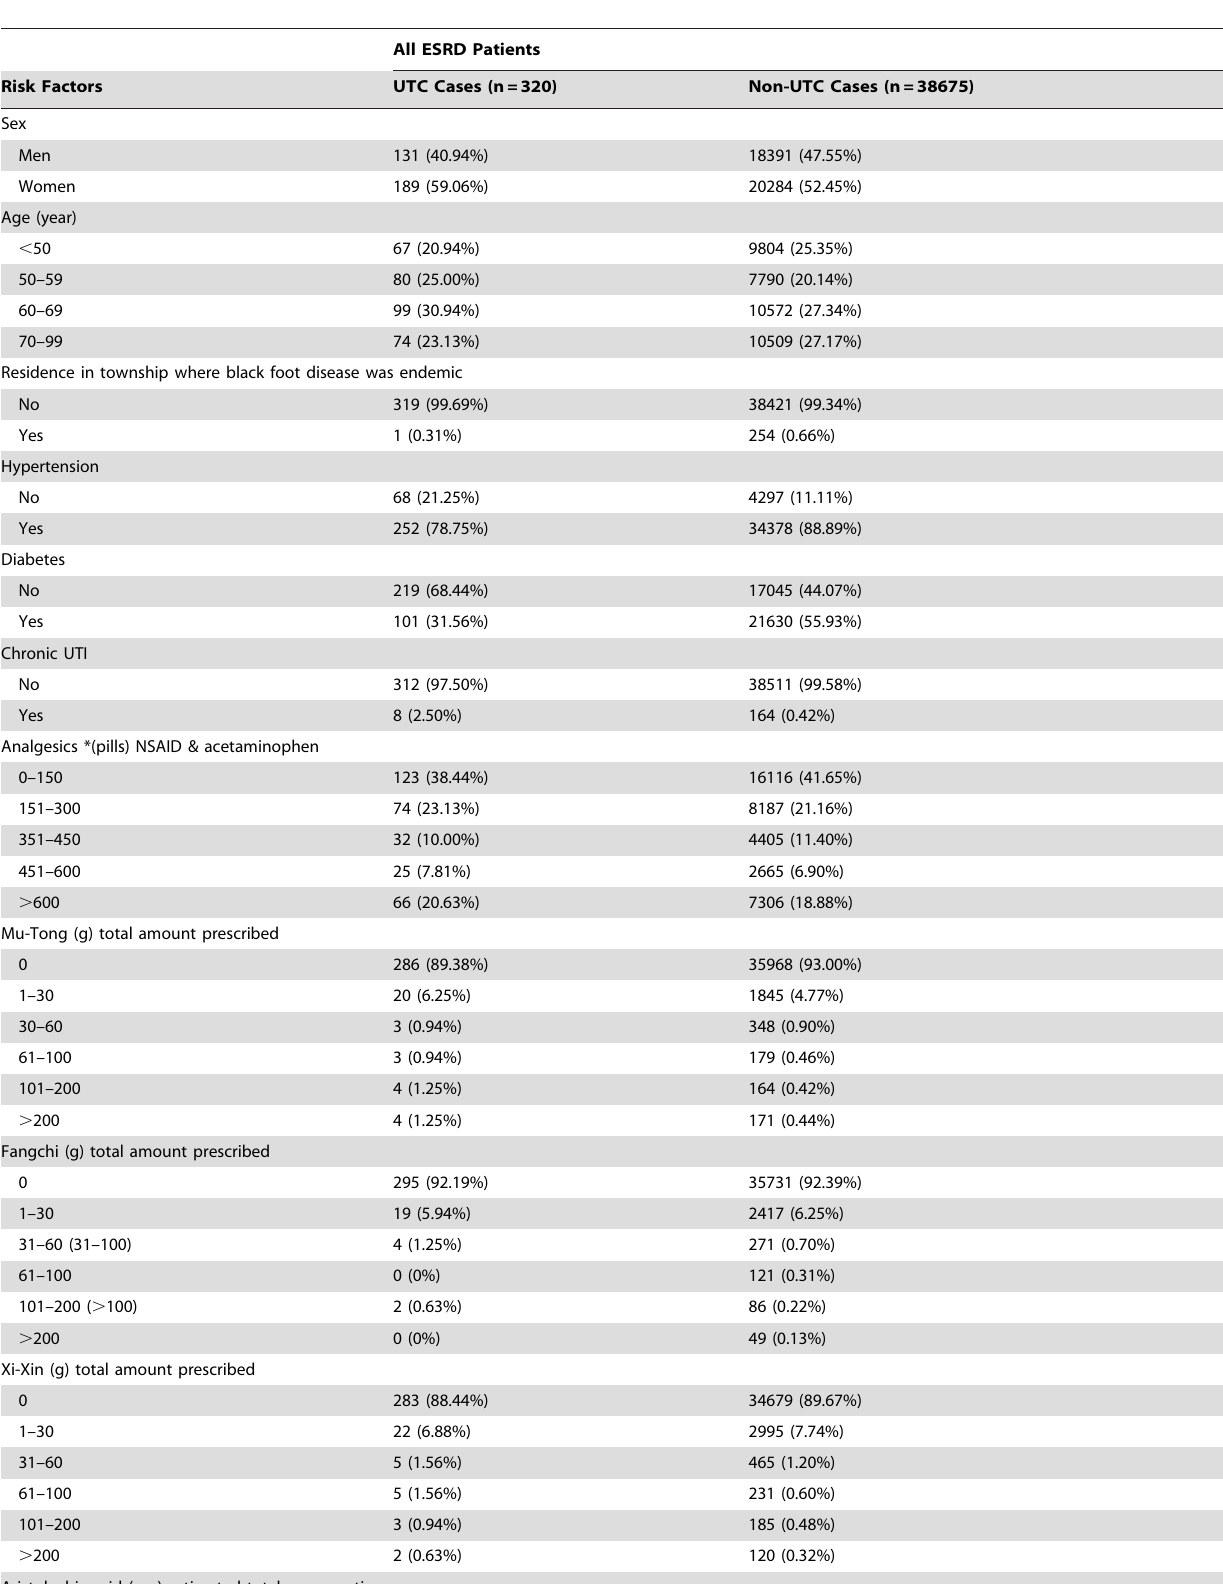
Table 1. Frequency distributions of various risk factors for the occurrence of urinary tract cancers (UTC) stratified by different inclusion criteria in 38,995 patients with end-stage renal disease